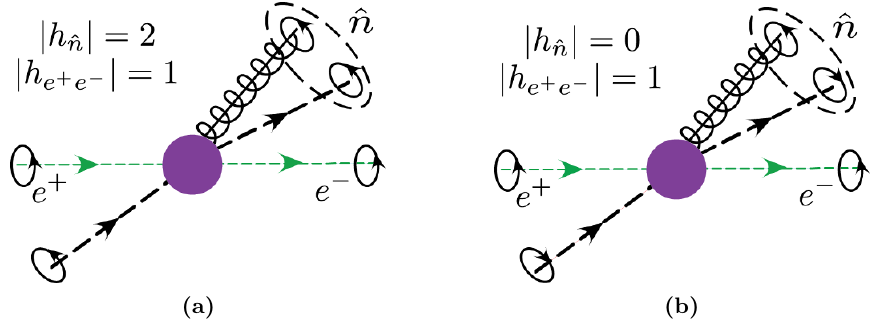
Figure 2. A illustration of the helicity selection rule for e + e (cid:0) ! dijets. In a) the collinear particles along the n axis carry j h = 2 j , and have a vanishing projection onto the J e (cid:6) current. In b), the collinear particles carry j h = 0 j and therefore have a non-vanishing projection onto the J e (cid:6)